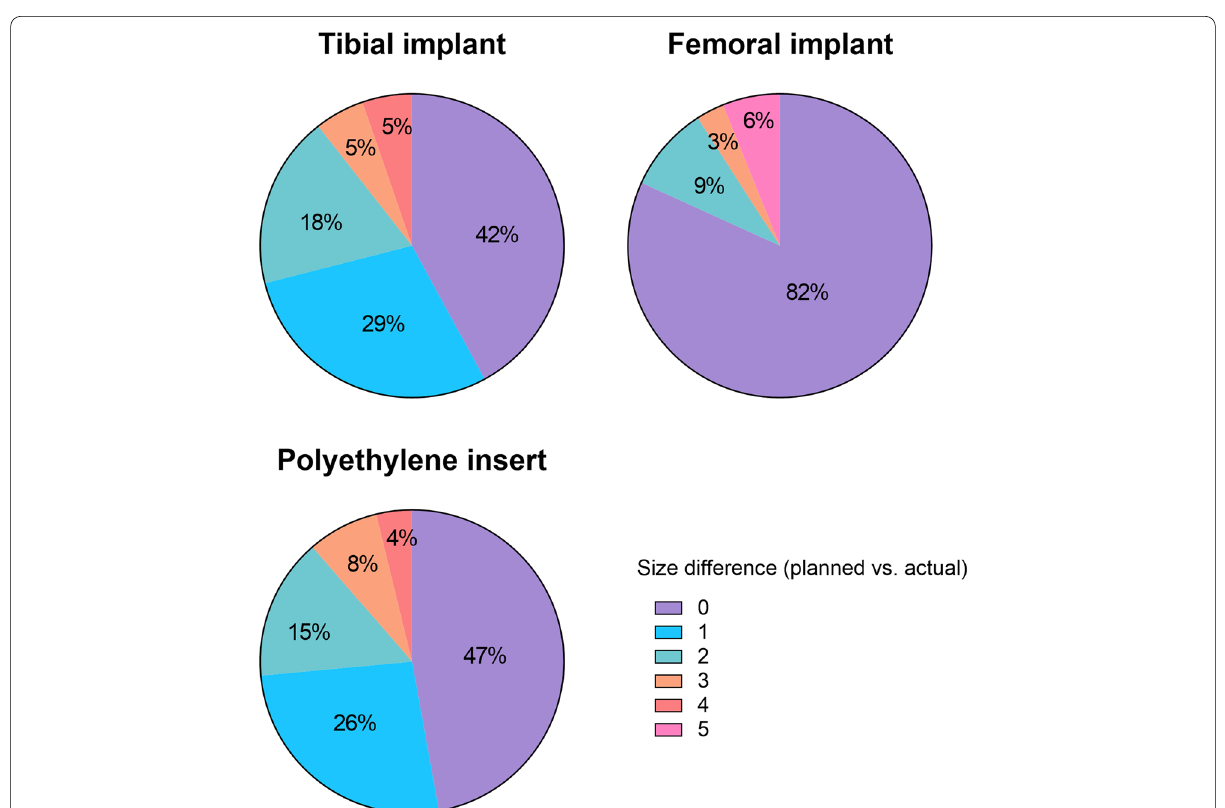
Fig. 3 Comparison of implant component planning accuracy with ROSA TKA (planned vs.